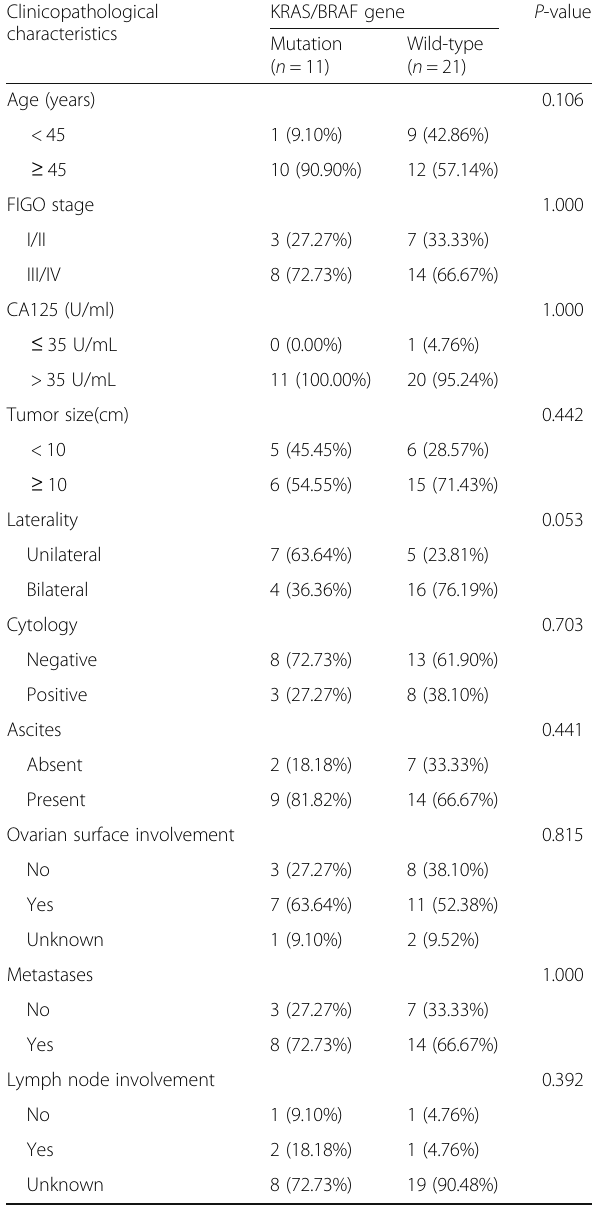
Table 1 Clinicopathological characteristics and KRAS and